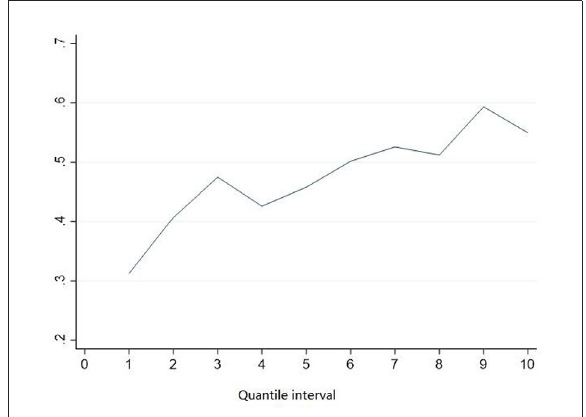
FIGURE2 Means of positive education matching between household per capita income quartiles.